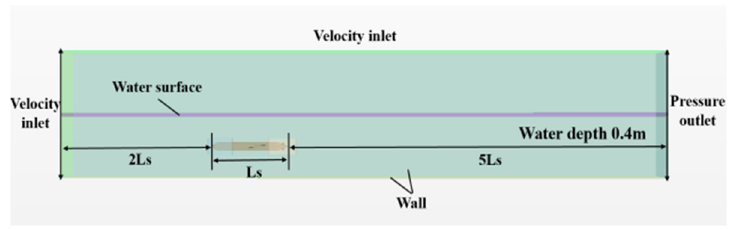
Figure 17. Numerical towing tank with the boundary conditions.